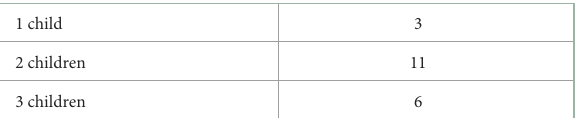
TABLE 2 Martial status.